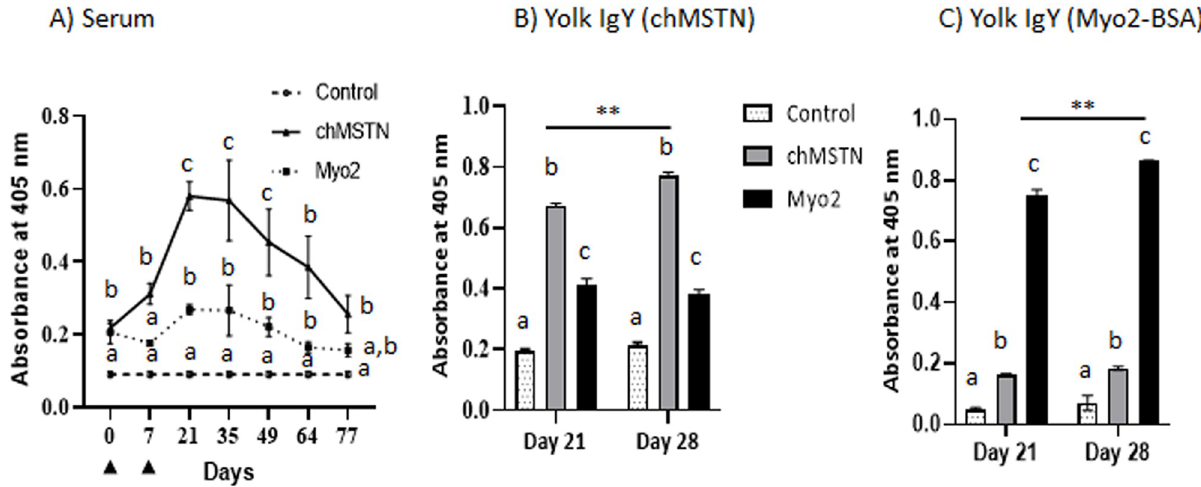
Fig 4. Antibody titer dynamics of immunized hens and egg yolk against chMSTN. A) Diluted (1:2,000) serum was used for titer determination. Serums were collected from the Control (n = 6), chMSTN (n = 3), and Myo2 (n = 3) hens, respectively. Arrowheads in the X-axis indicate the injection of antigen. Data are mean ± SEM. 2.5 μ g/mL egg yolk IgY from three hens of each group were used for titer measurement with chMSTM (B) or Myo2 conjugated to BSA (C) as a coating antigen. The mean difference among the three groups within days and the mean difference between days 21 and 28 within treatment groups were analyzed by Tukey’s test. Different alphabets within the days are different at P < 0.05. Data are mean ± SEM. �� , P < 0.01.